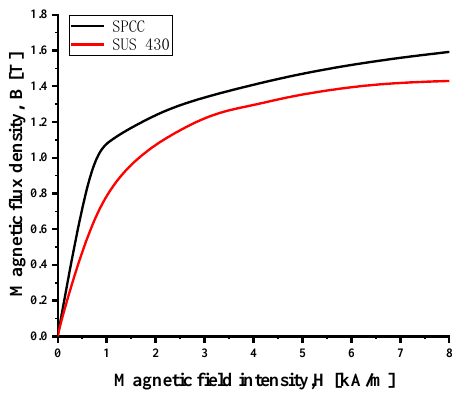
Figure 2. B-H curve of SPCC and SUS 430.